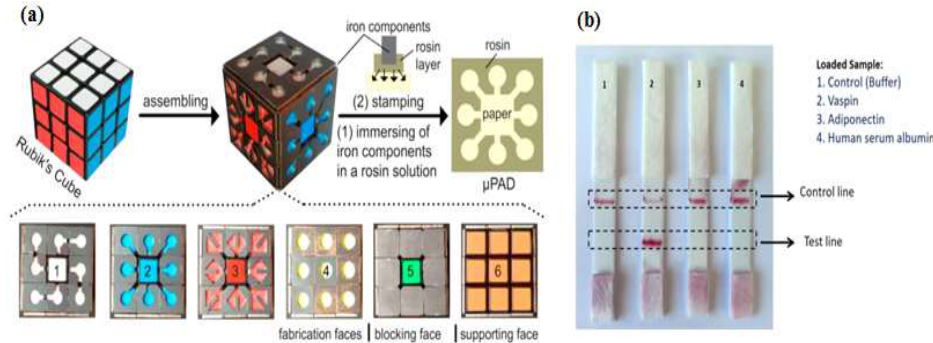
Figure 6. Paper-based analytical device aptasensor. ( a ) Rubik’s cube-based µPAD aptasensor to generate a hydrophobic barrier and a testing zone. Parts 1–5 have different functions while the 6th part acts as a “bare” or support part only. Reproduced with permission from reference [78]. Copyright 2017 Elsevier; ( b ) Lateral strip test for specific detection of vaspin. This device was equipped with a control as indicator. Reproduced with permission from reference [82]. Copyright 2017